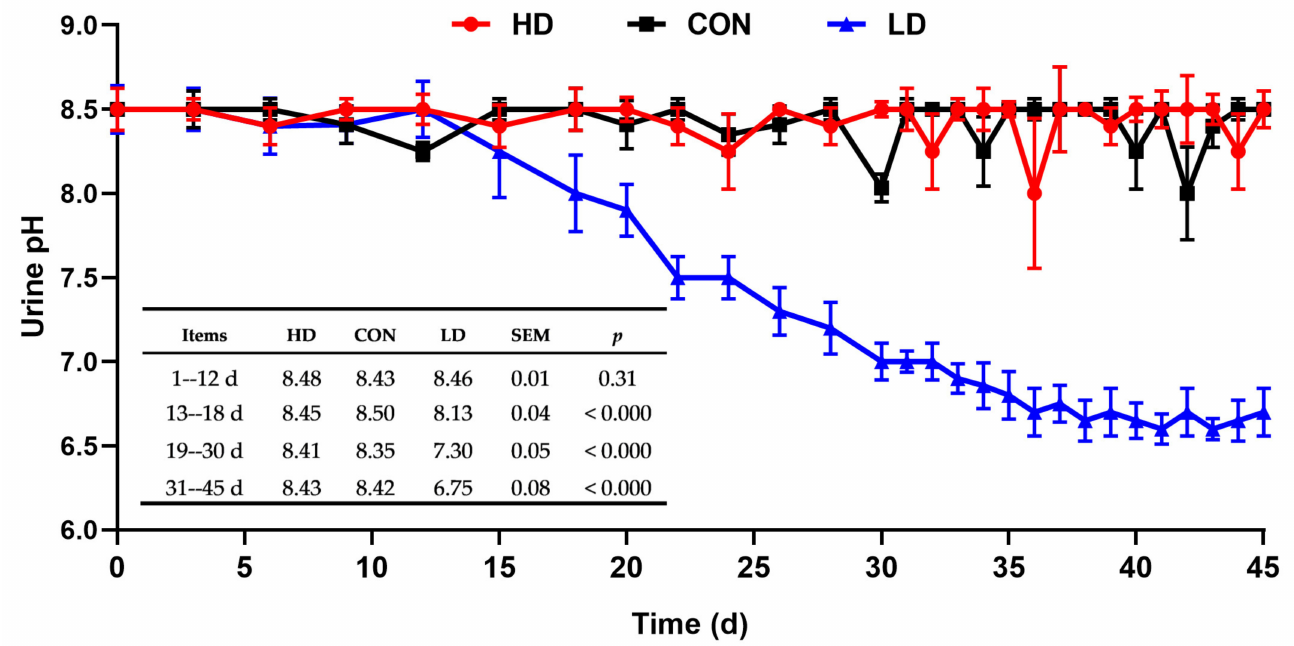
Figure 3. Urine pH variation of female goats fed varying dietary cation-anion difference throughout the experiment.